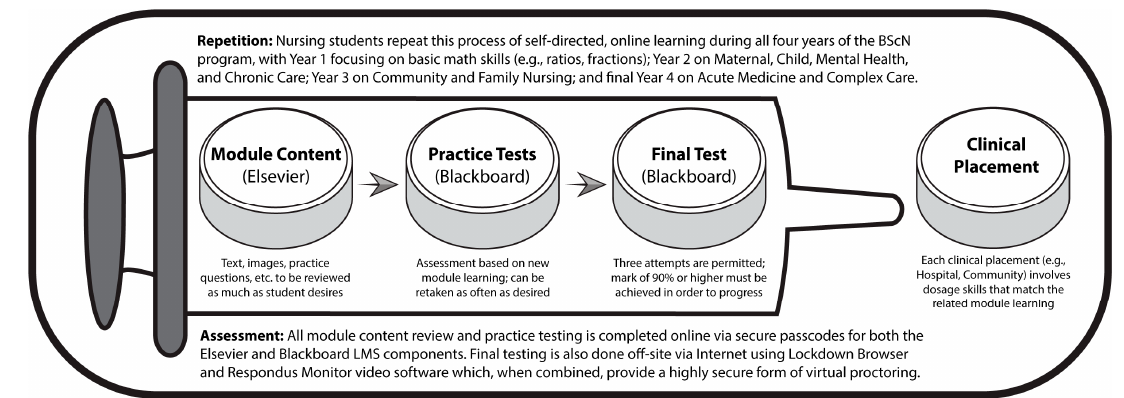
Figure 2. Overview of the new Dosage Calculation Competency Test (DCCT) model.